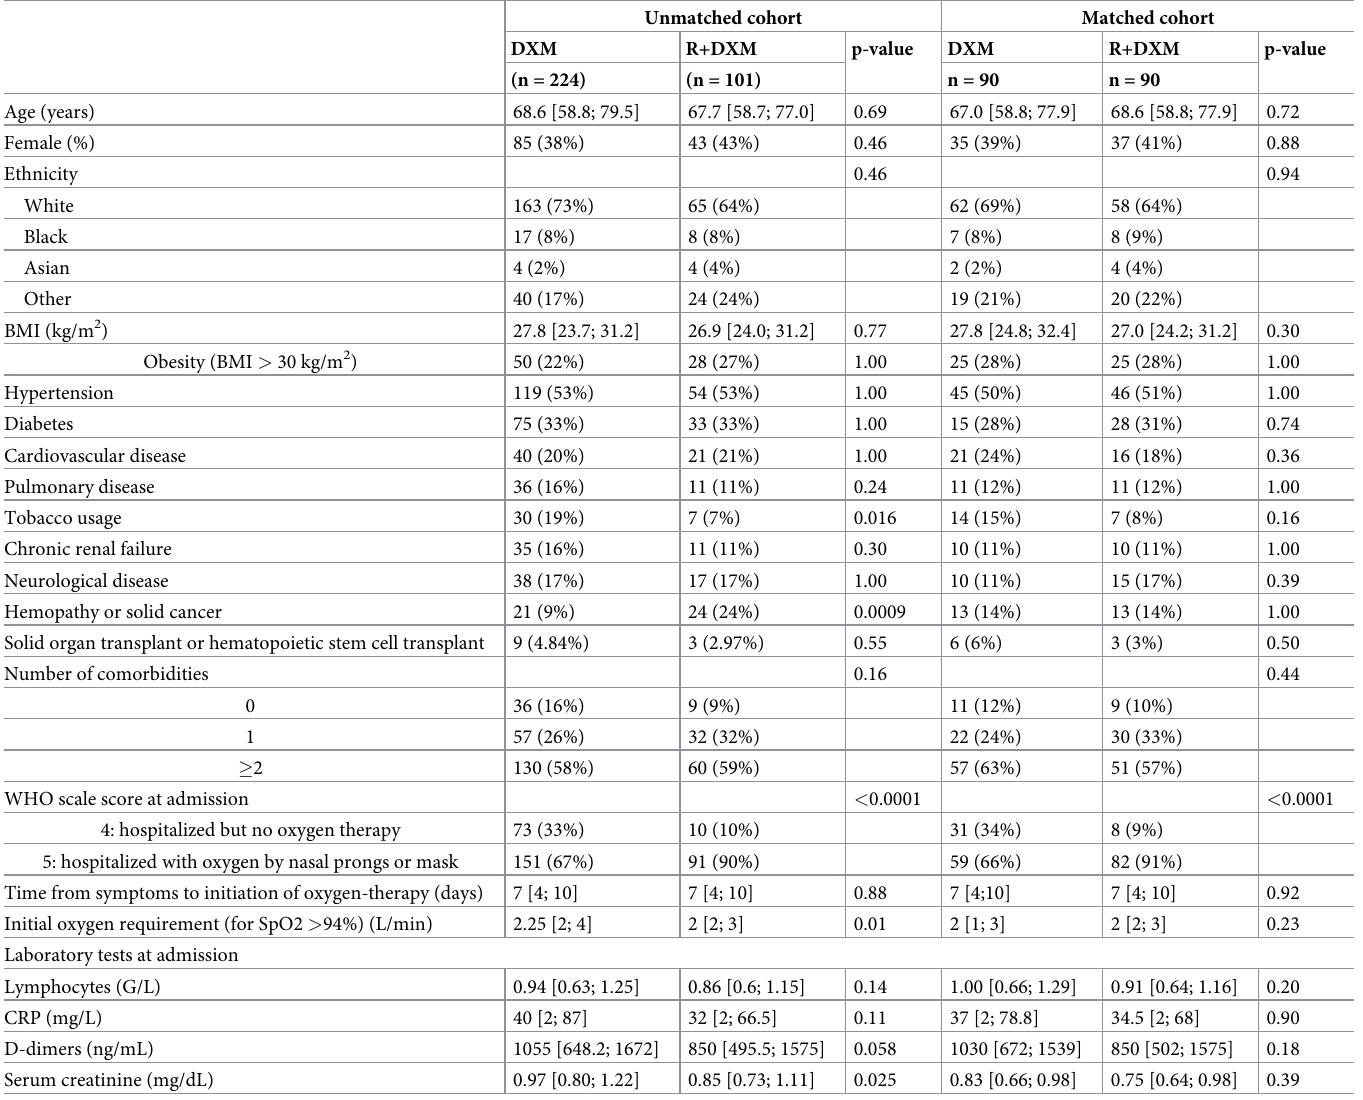
Table 1. Baseline demographic and clinical characteristics of the patients (unmatched and matched